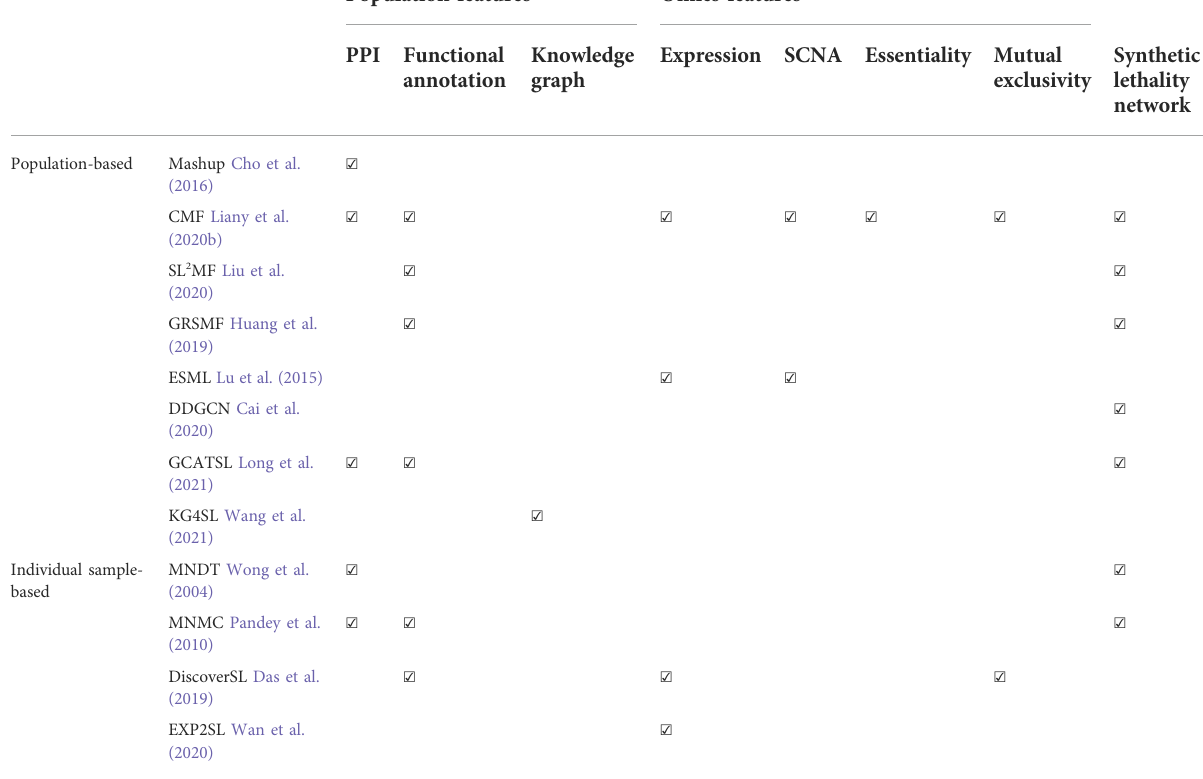
TABLE 3 Population and omics features for machine-learning predictive